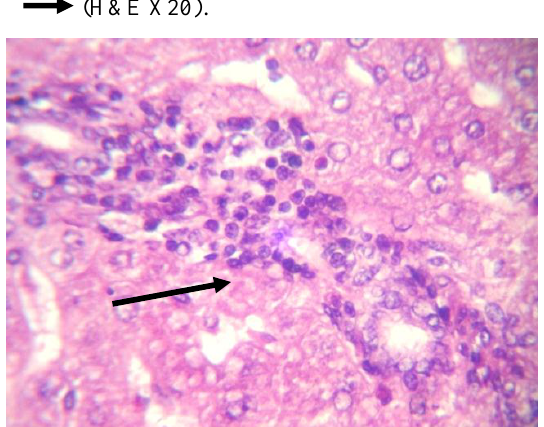
Fig 9: Microscopic section of liver from 1st immunized group at 20 days post challenge show moderate cellular swelling and vaculation of hepatocyte (H&E X20).